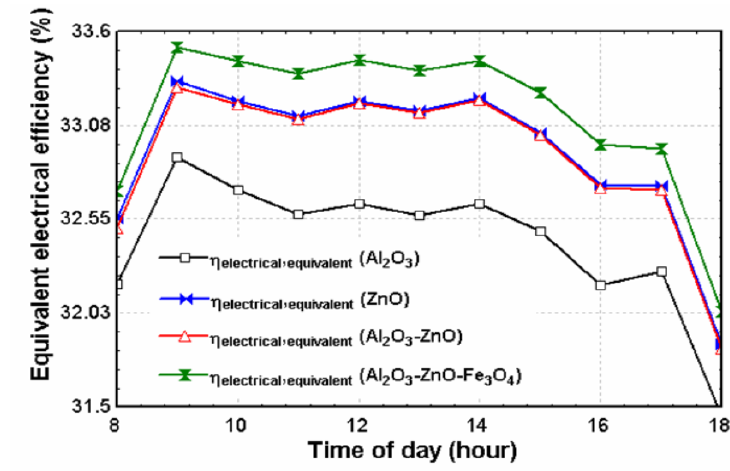
Figure 15. Equivalent electrical efficiency of PV/T system.